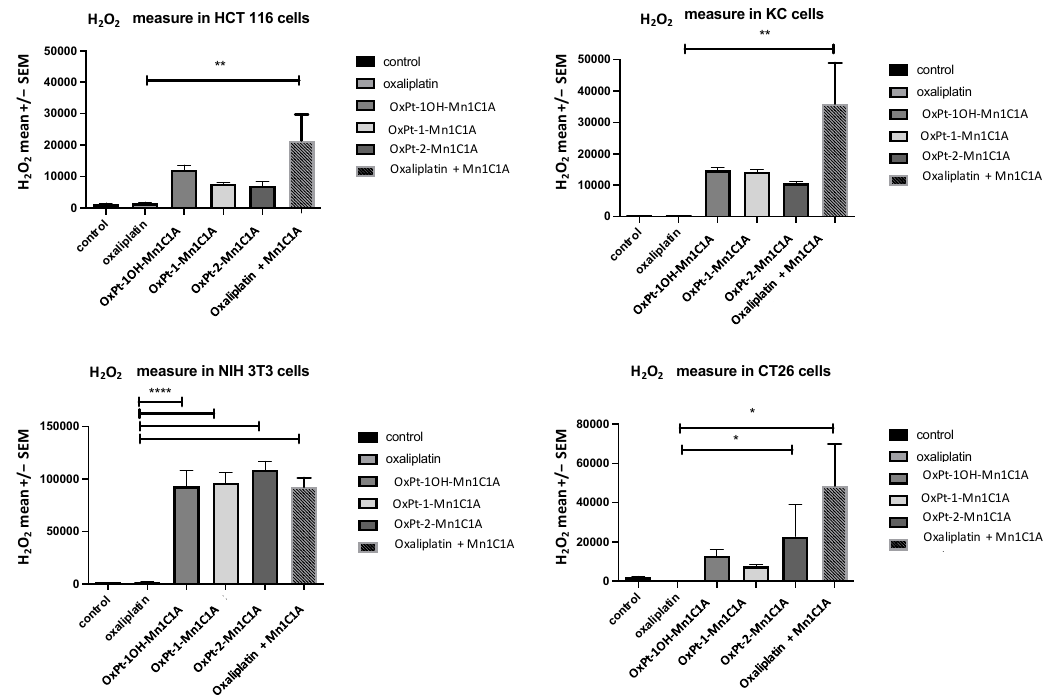
Figure 2. H 2 O 2 levels in vitro. Mean H 2 O 2 levels (fluorescence intensity) as measured by spectropho- tometry (H 2 -DCFDA) in cell lines treated with vehicle, oxaliplatin, OxPt-1OH-Mn1C1A, OxPt-1- Mn1C1A, OxPt-2-Mn1C1A, and Mn1C1A + oxaliplatin at 2.5 μ M, 5 μ M, and 10 μ M for 24 h. The p - values are denoted as follows: * p < 0.05, ** p < 0.01, and **** p < 0.0001. H 2 O 2 levels were higher in all cell lines with conjugate compounds or with Mn1C1A + oxaliplatin compared to oxaliplatin alone ( p < 0.05). Mean O 2. − levels in all cell lines were measured after 24 h of treatment exposure. O 2. − levels were significantly higher in HCT 116 and NIH 3T3 cell lines treated with Mn1C1A + oxaliplatin than oxaliplatin alone. In HCT 116 cells, oxaliplatin + Mn1C1A significantly increased O 2. − levels compared to oxaliplatin alone ( p < 0.05). In CT26 and KC cells, no significative difference was observed in O 2. − levels. In NIH 3T3 cells, OxPt-2-Mn1C1A and oxaliplatin + Mn1C1A significantly increased O 2 . − levels compared to oxaliplatin alone ( p < 0.05) (Supplementary Figure S23). GSH cellular levels, reflecting the detoxification sys- tem, were stable in CT26, HCT 116, and NIH 3T3 and lowered in KC cells treated with MnSOD mimetics (Supplementary Figure S24). 2.3. In Vitro Cell Viability Cell viability was assessed by crystal violet on day 2 after 24 h of treatment (3 Pt(IV) compounds, oxaliplatin alone, and Mn1C1A + oxaliplatin or vehicle, at 2.5 μ M, 5 μ M, and 10 μ M) (Figure 3). In vitro antitumoral activity was significantly higher in tumoral cell lines treated with Pt(IV) conjugate compounds and Mn1C1A associated with oxaliplatin compared to oxaliplatin alone. The antitumoral effect was proportional to H 2 O 2 levels.